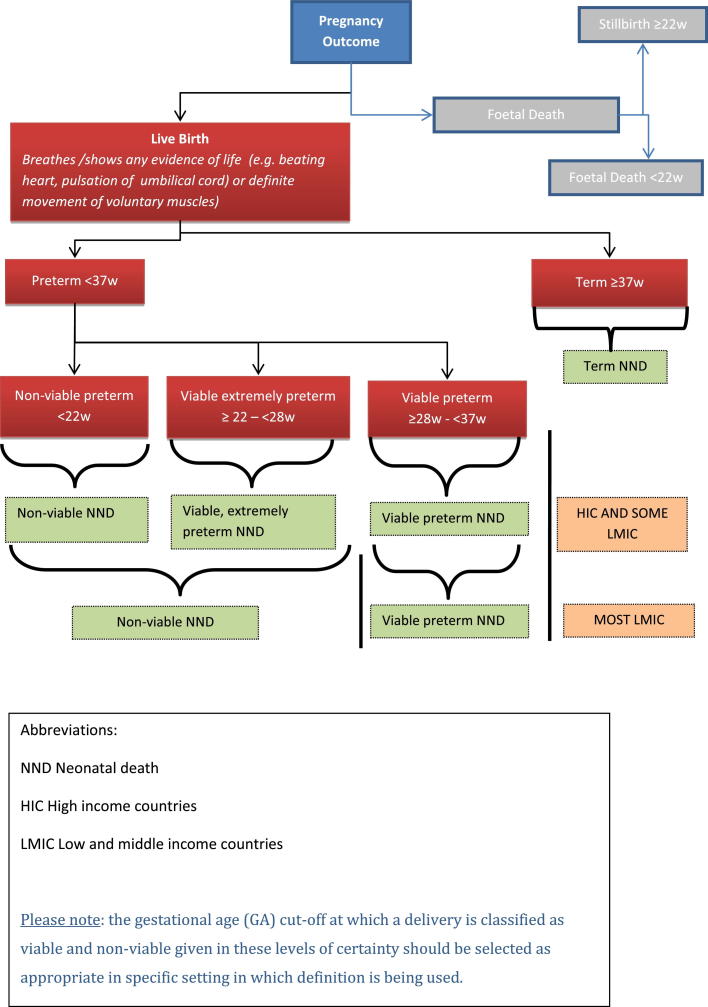
Algorithm for the classification of neonatal death.